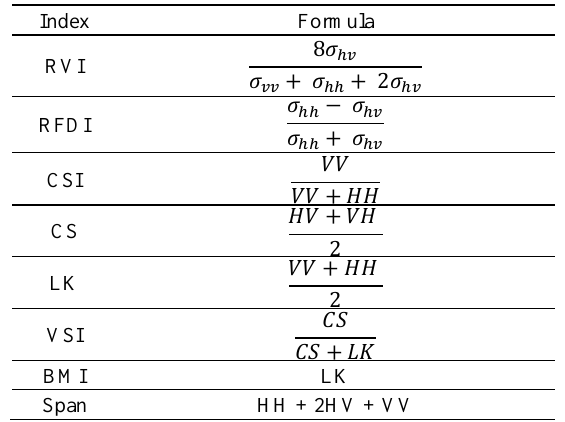
Table 2 . Formulas for generated indices and Span